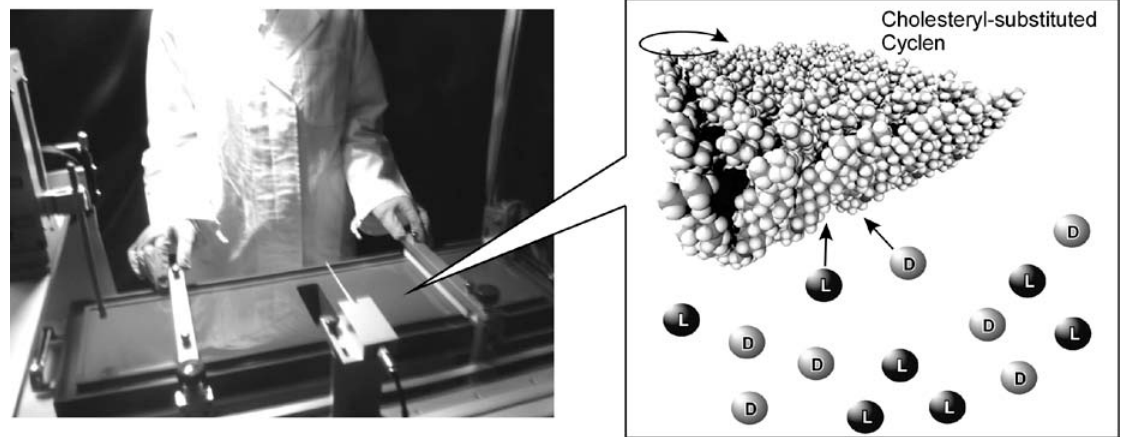
Figure 6. Mechanical control of chiral guest binding to monolayer of cholesteryl- substituted